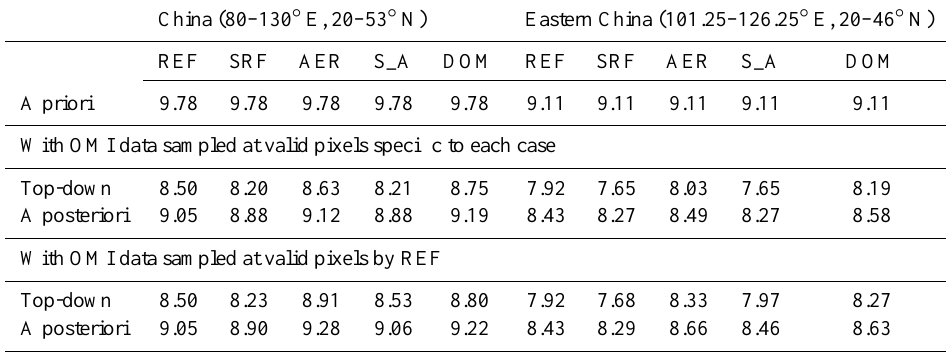
Table 3. A priori, top-down and a posteriori emissions of NO ∗ x